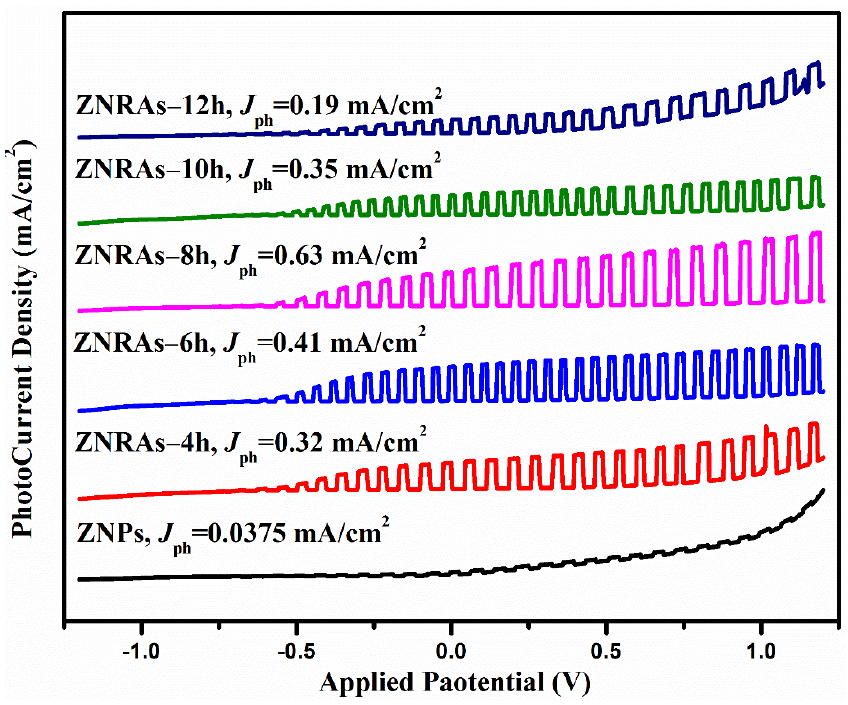
Figure 11. LSV response of ZNPs (seed layer) and ZNRAs prepared at various growth times.